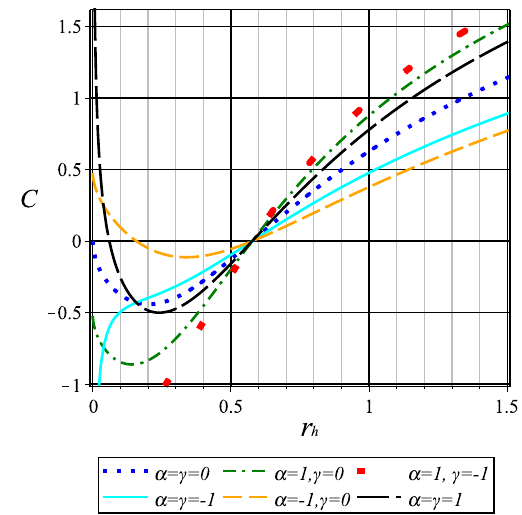
Fig. 4 Internal energy of LMP solution in spherical space in terms of the black hole horizon for l = 1 and a =